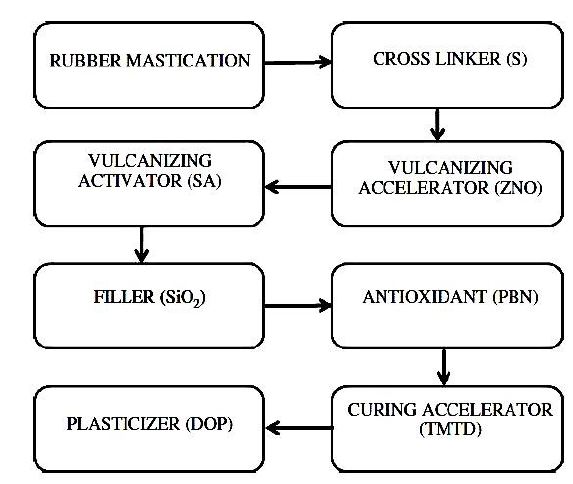
Figure 1: Sequence of constituents’ addition in preparation